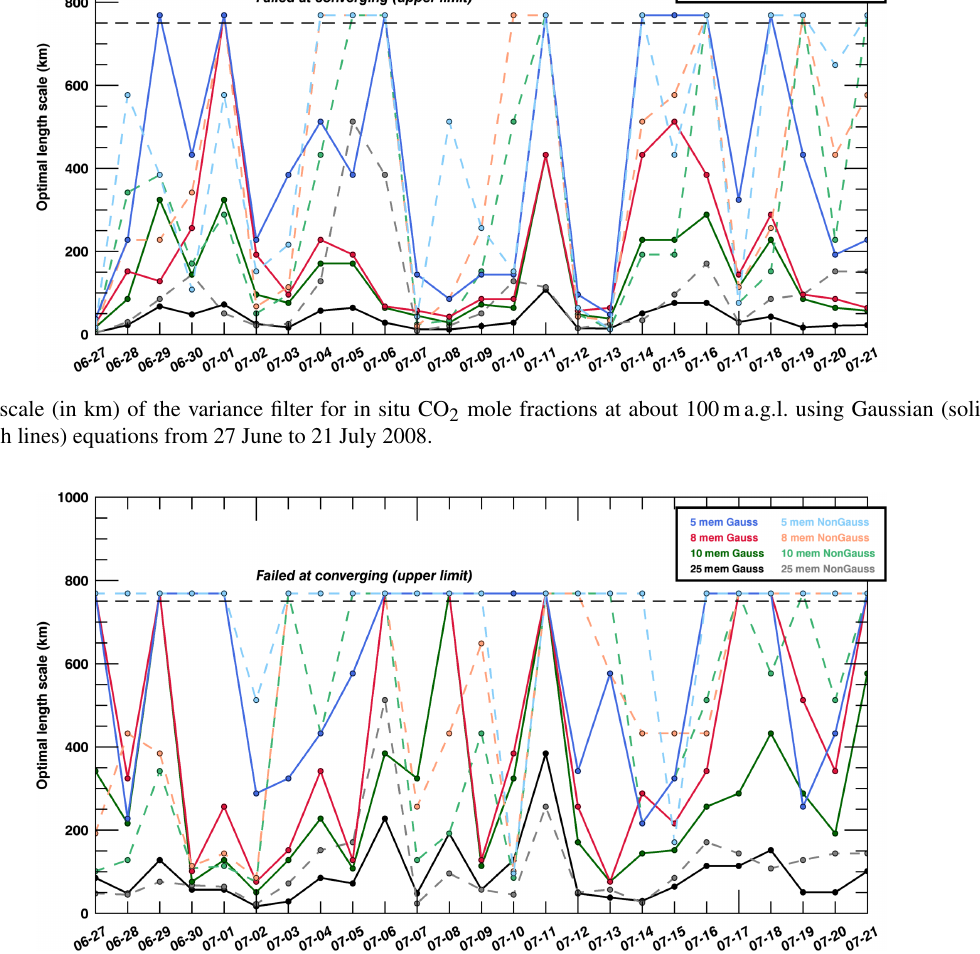
Figure 3. Length scale (in km) of the variance filter for XCO 2 total-column dry air mole fractions using Gaussian (solid lines) and non- Gaussian (dash lines) equations from 27 June to 21 July